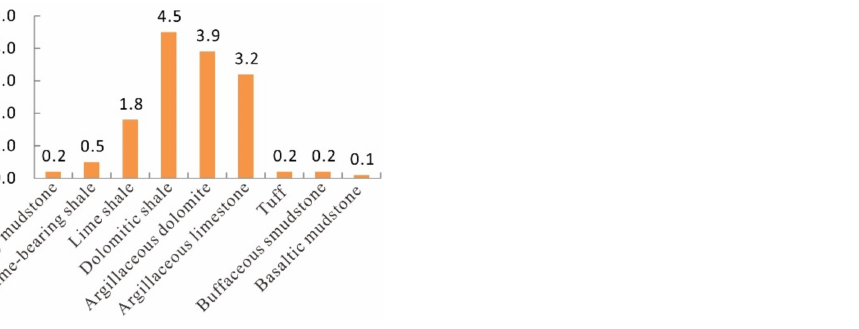
Figure 3. Relationship between lithology and organic matter abundance in main source rocks.